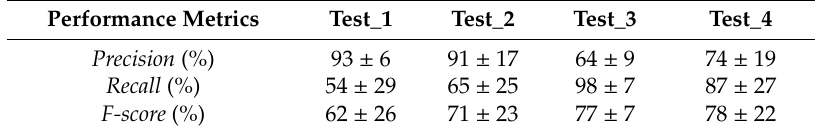
Table 3. Mean and standard deviation values of the performance metrics regarding the Figure 10. Performance Metrics